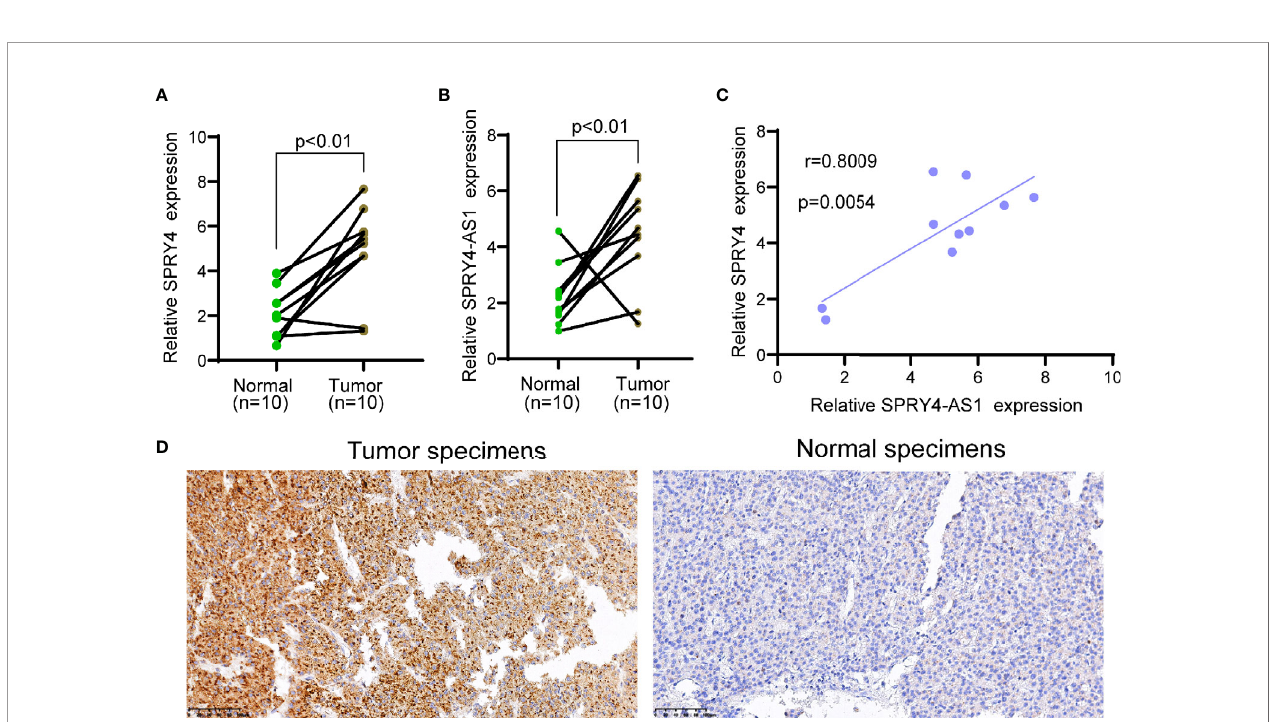
FIGURE 4 | The upregulation of SPRY4 antisense RNA 1 (SPRY4-AS1) and SPRY4 in hepatocellular carcinoma (HCC) specimens. (A, B) RT-PCR for the levels of (A) SPRY4 and (B) SPRY4-AS1 in 10 pairs of HCC specimens and matched non-tumor specimens. (C) Association between SPRY4-AS1 and SPRY4 expression in 10 HCC specimens. (D) Immunohistochemical staining of 10 pairs of